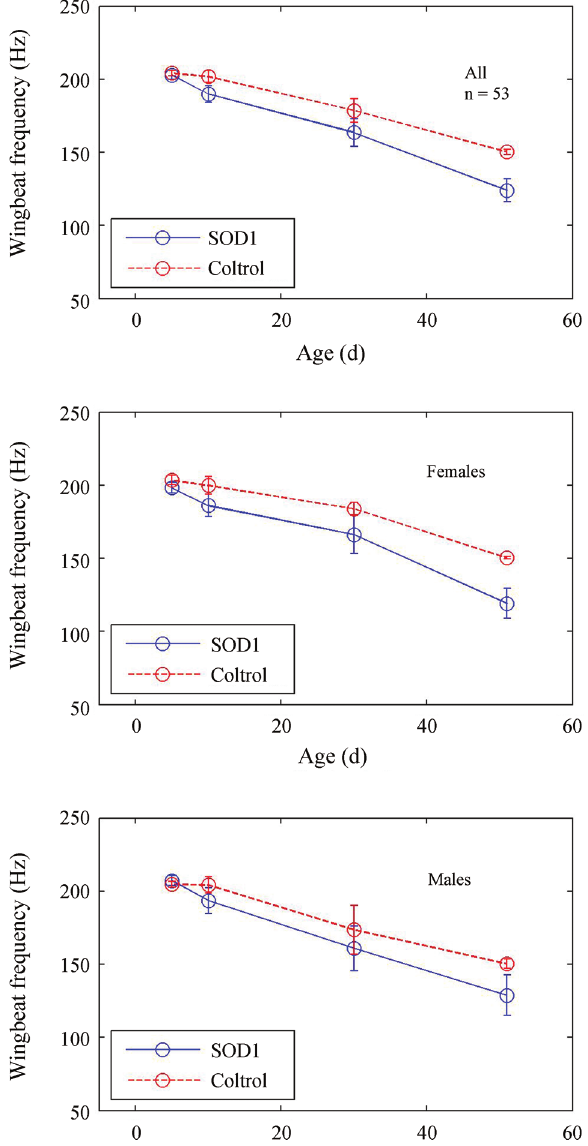
Figure 4 - Wingbeat frequency as a function of age for the hSOD1 and controlgroups(toppanel).Middleandbottompanelsshowdataforfemale and male flies respectively. Error bars represent one standard